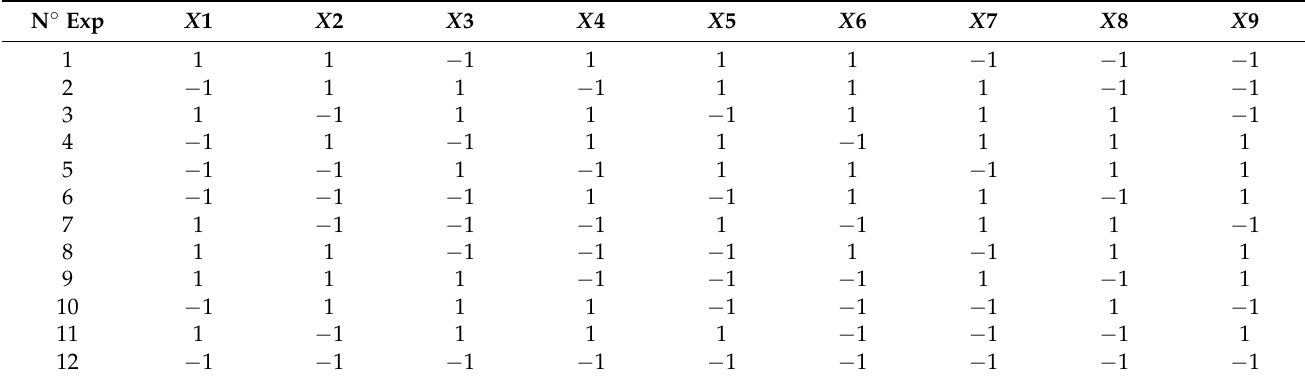
Table 3. Experimental matrix.